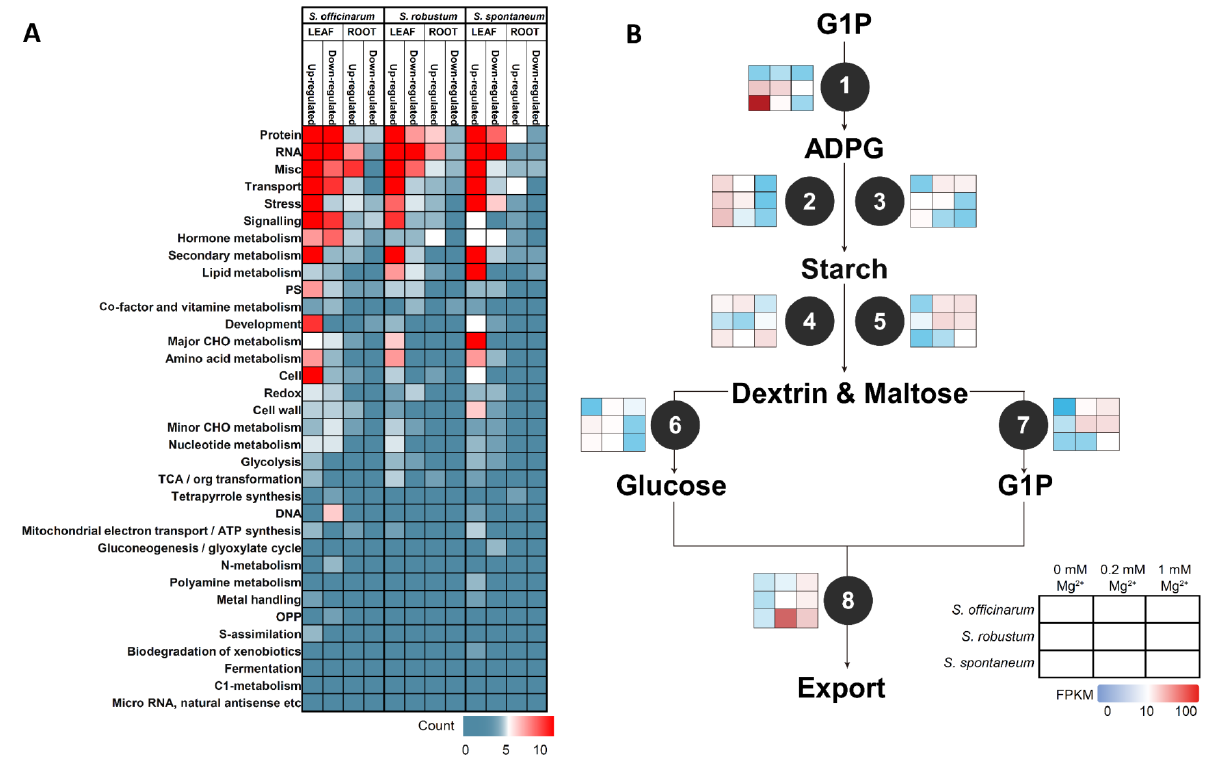
Figure 4. Mapman functional class enrichment for DEGs in leaves and roots of three Saccharum species ( A ) and schematic of the starch metabolism of sugarcane ( B ). The heat maps depict gene expression along with Mg concentration in leaves of three Saccharum species. 1, Glucose − 1 − phosphate adenylyltransferase; 2, Soluble starch synthase; 3, Starch branching enzyme; 4, Alpha − amylase; 5, Alpha − glucan water dikinase; 6, Glucose − 1 − phosphate adenylyltransferase; 7, Alpha − glucan phosphorylase; 8, Phosphate/phosphate translocator.Note: G1P: Glucose − 1 − phosphate;ADPG: Adenosine 5 ′ − Diphosphoglucose.